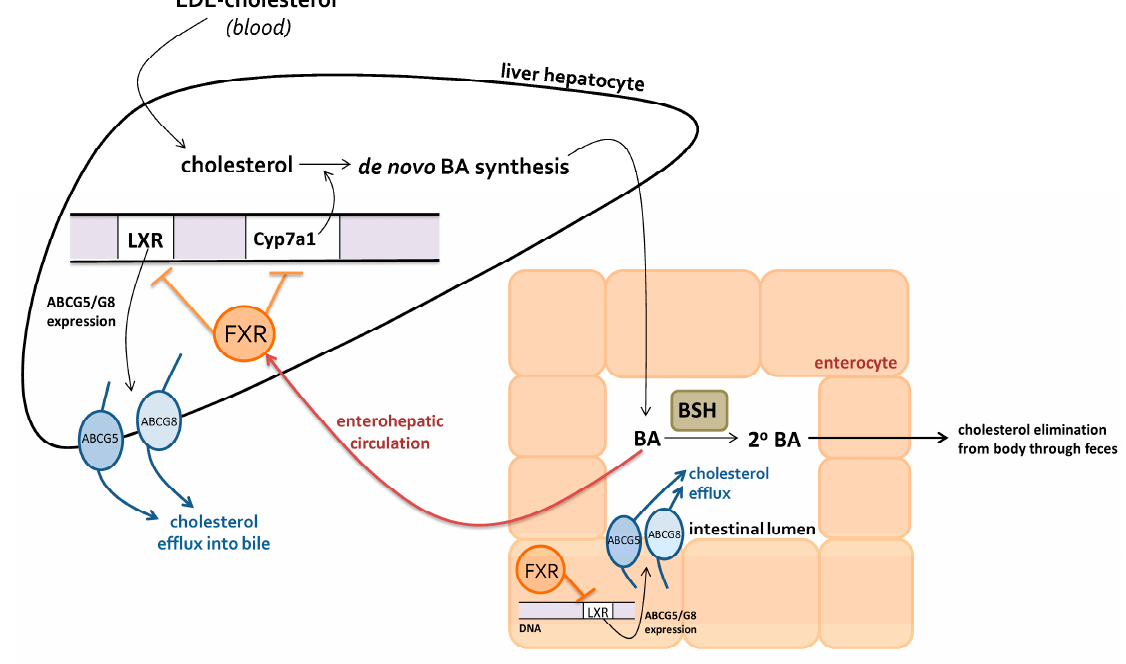
Figure 3. Regulation of cholesterol elimination through bacterial bile-salt hydrolase (BSH) mediated bile acids (BA) activation of hepatic farnesoid X receptor (FXR).